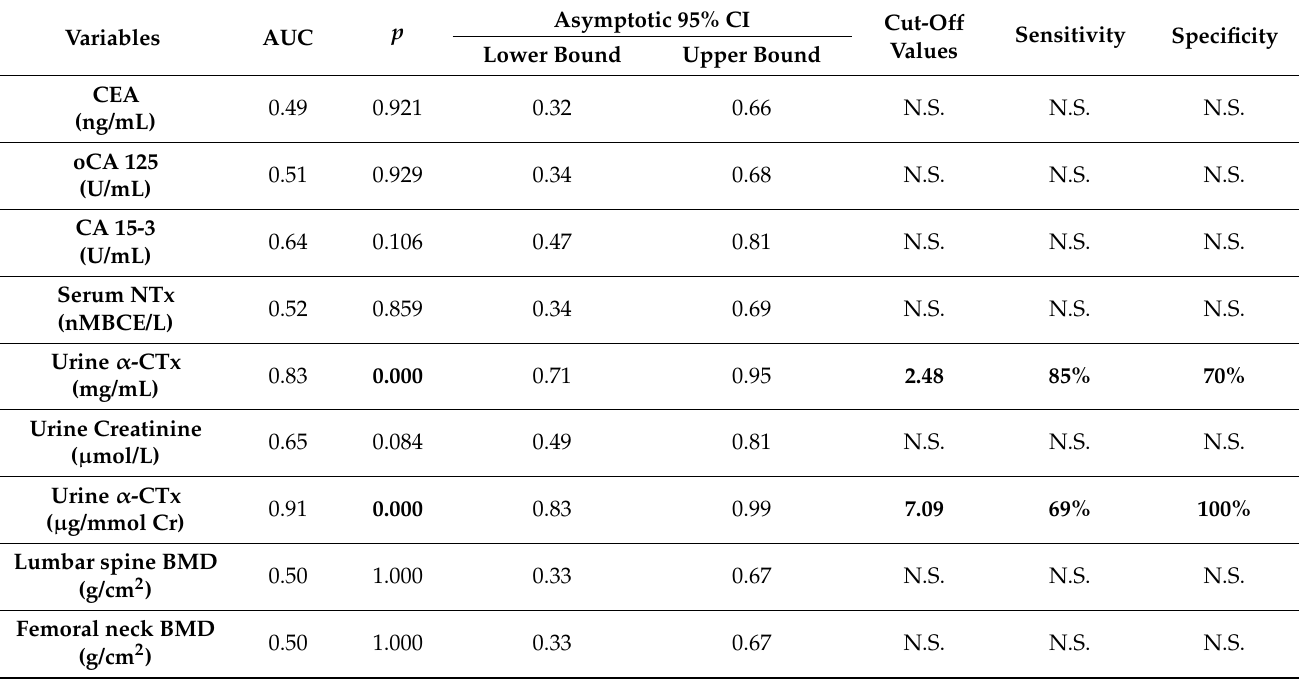
Table 4. Cut-off points, sensitivity, specificity, and AUC for distinguishing breast cancer patients with metastasis from breast cancer patients without